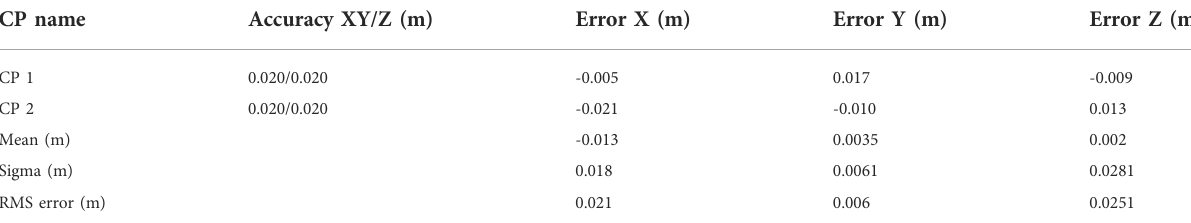
TABLE 8 RMS error of